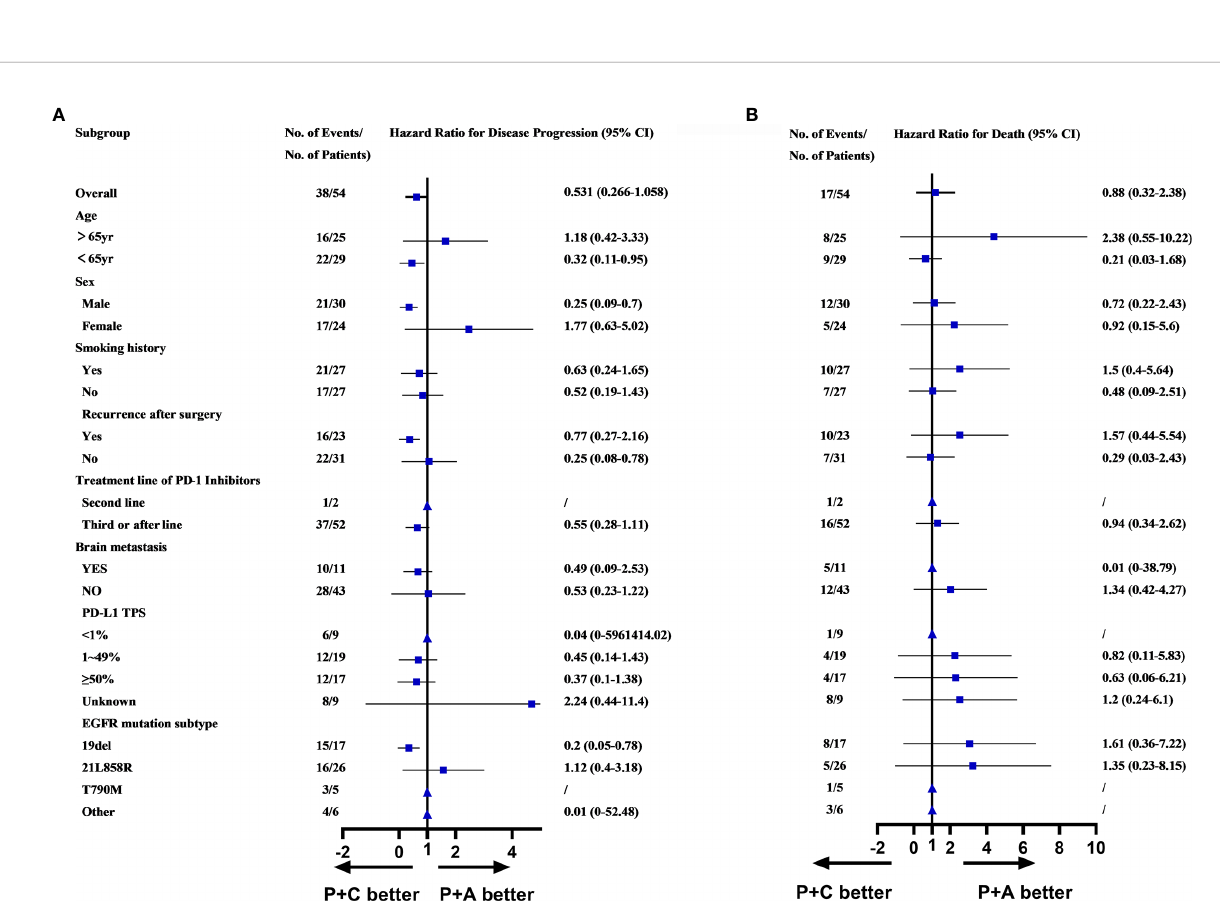
FIGURE 4 | (A) Subgroups analysis of PFS in P+C and P+A groups. (B) Subgroups analysis of OS in P+C and P+A groups. ( ▲ Represented HR cannot be calculated due to the